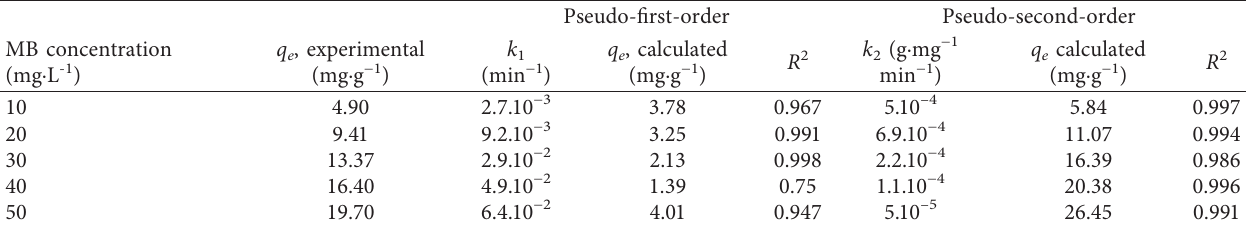
Table 1: Pseudo-first-order and pseudo-second-order parameters for adsorption of methylene blue ions onto sediments at different concentrations.